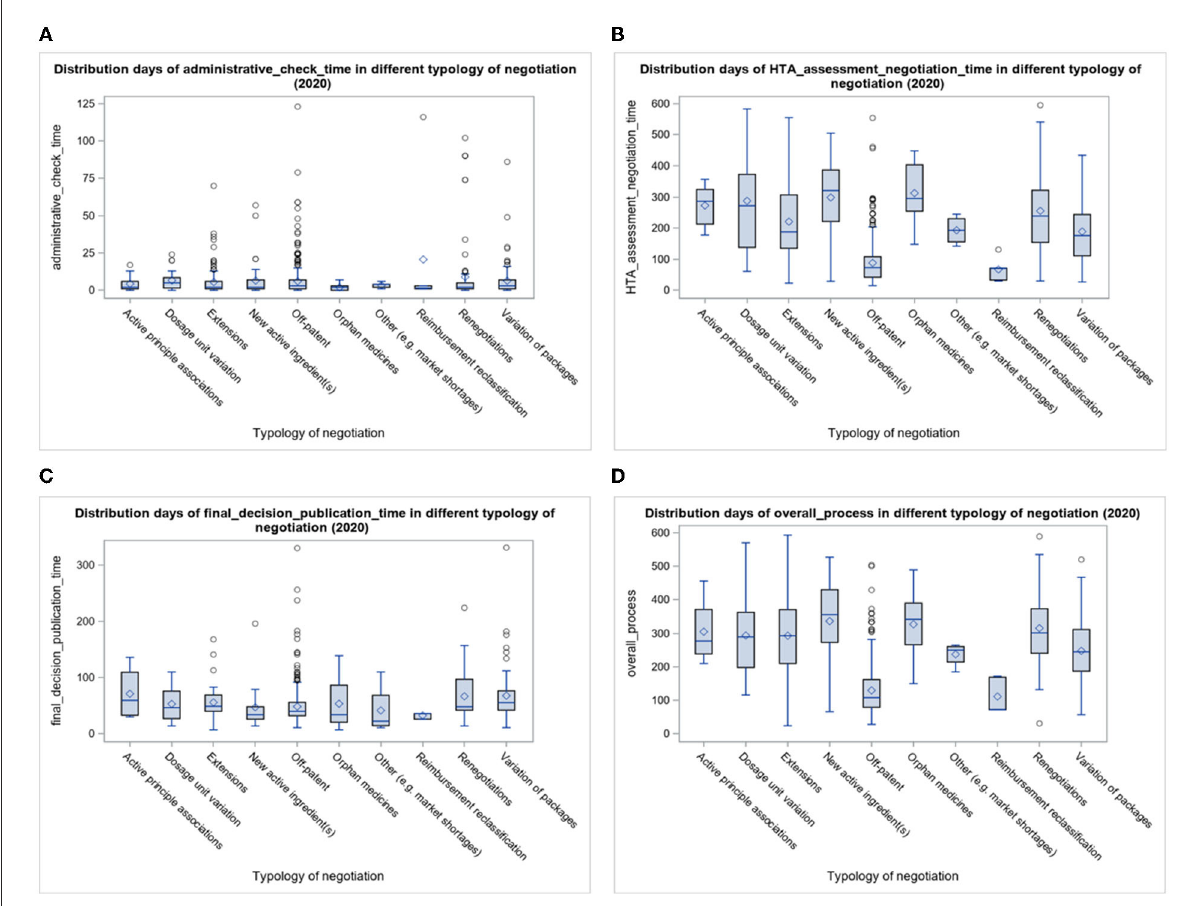
FIGURE4 (A–D) Boxplots of time days indicators by typology of